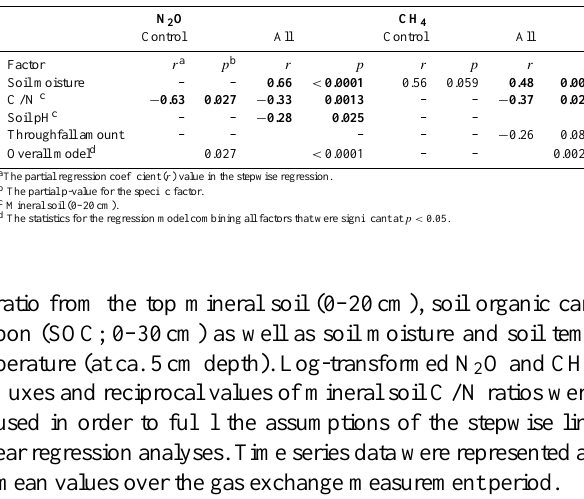
Table 4. The results of the stepwise regression analyses for con- trol plots ( n = 13) only and all plots (treatments+controls, n = 30). Only significant ( p < 0 . 05; bold) and marginal significant effects ( p < 0 . 1) are